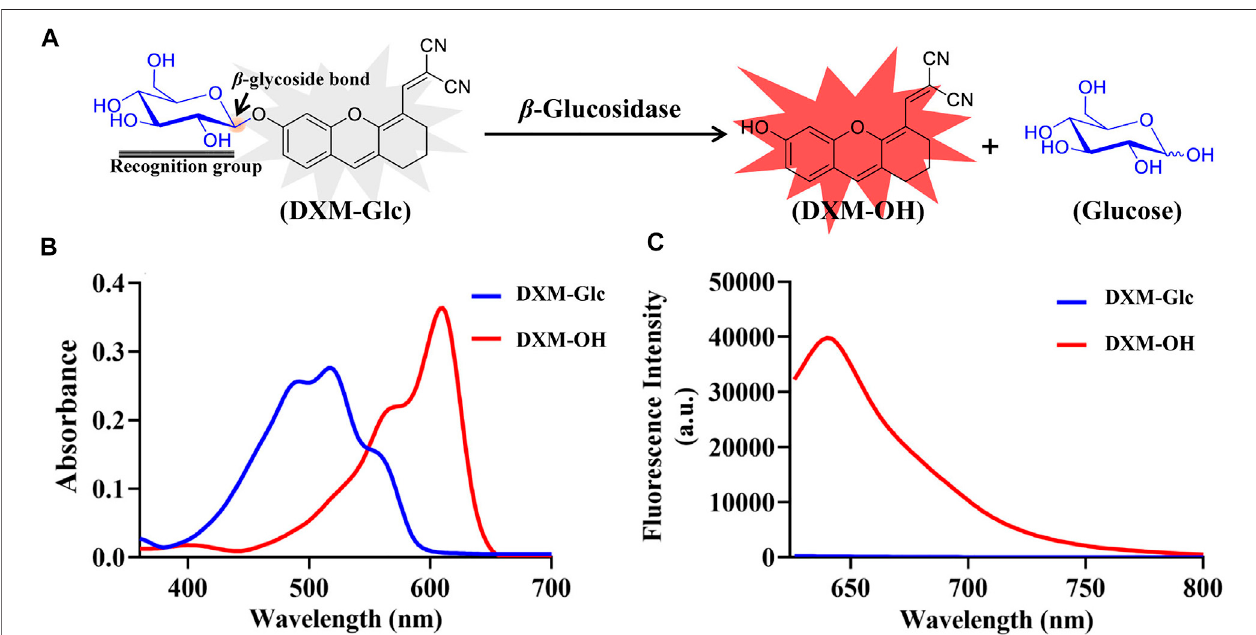
FIGURE 1 | Design of fl uorescent probe for β -Glc. (A) Illustration for the hydrolysis of DXM-Glc mediated by β -Glc. (B) Absorbance spectra of DXM-Glc and DXM-OH . (C) Fluorescence spectra of DXM-Glc and DXM-OH ( λ ex 600 nm).